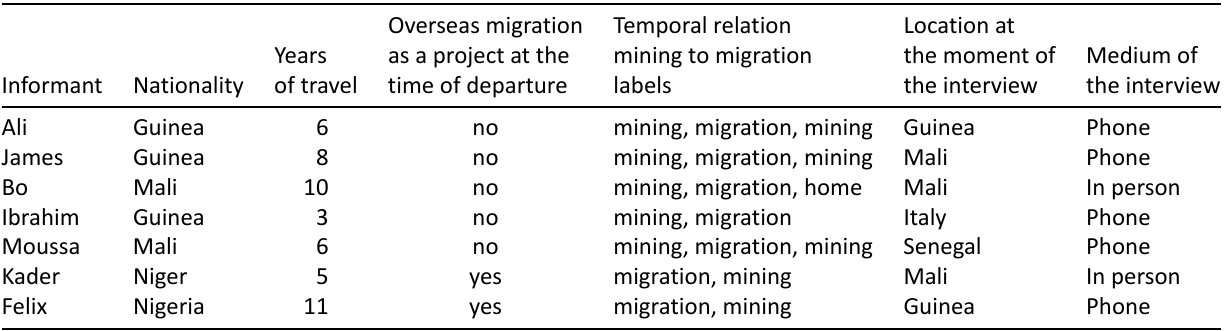
Table 1. Informants selected for in-depth trajectory interviews (the names used are